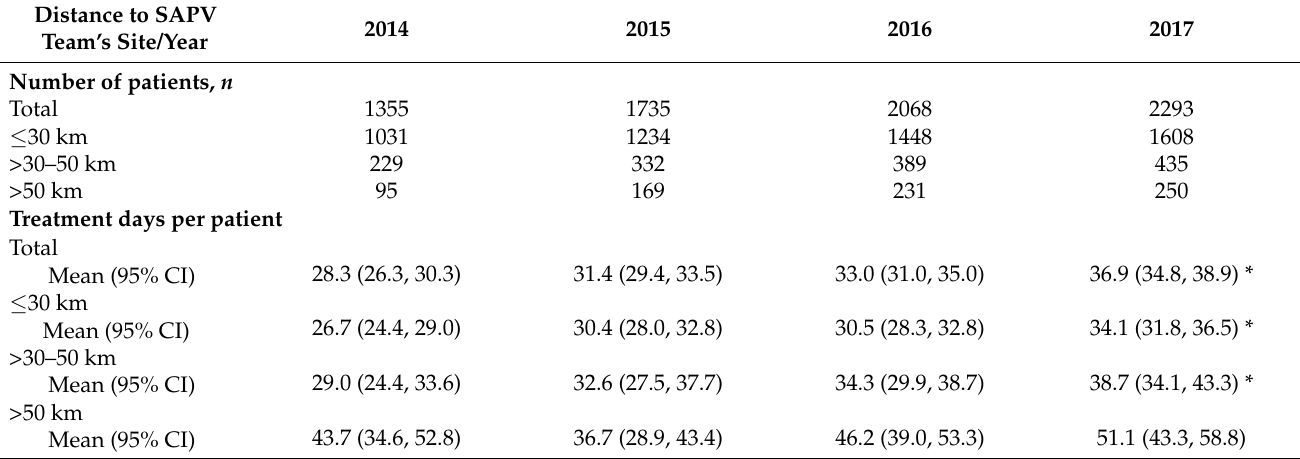
Table 4. Number of patients and treatment days per patient, by distance and